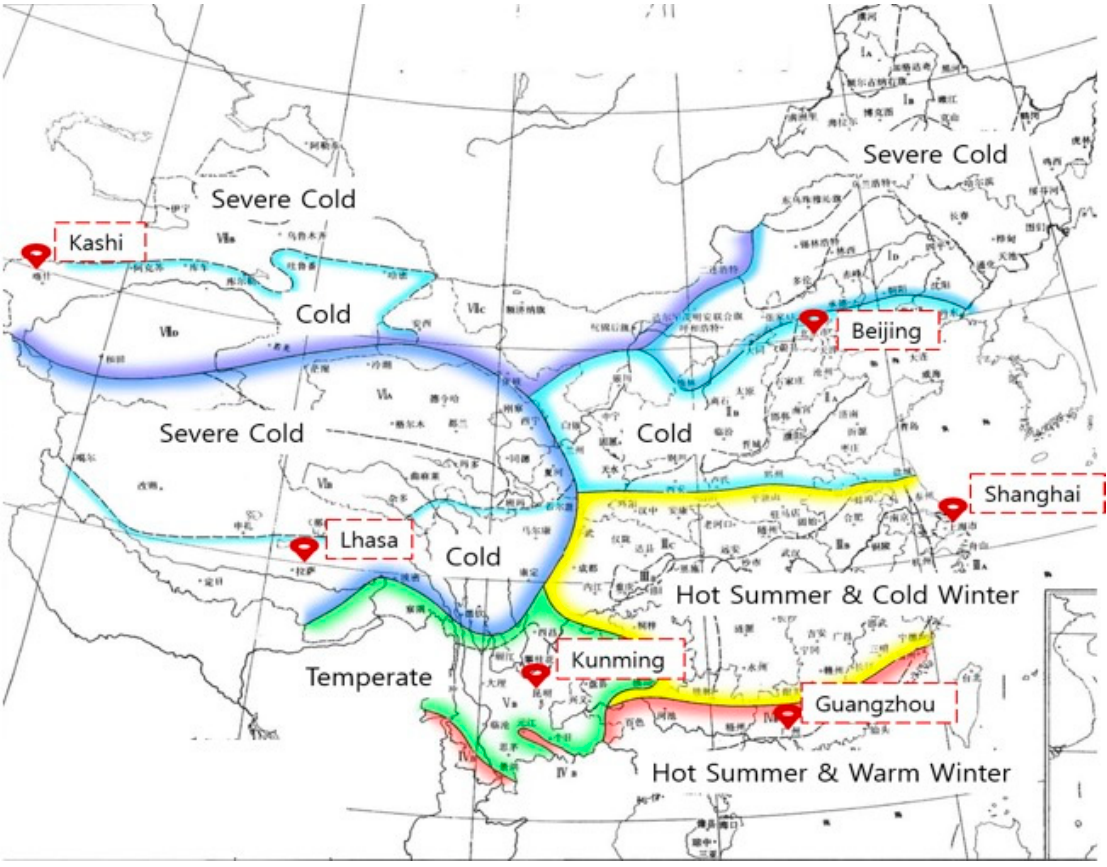
Figure 5. Selected cities on the climate distribution map of China. The six selected cities are part of six di ff erent climate regions, as shown in Figure 5. They are Beijing, Lhasa, Kashi (severe cold regions), Shanghai (hot summer and cold winter regions), Guangzhou (hot summer and warm winter regions), and Kunming (mild regions). These have distinctly di ff erent outdoor air conditions and di ff erent annual changes. The first three cities belong to a relatively dry climate region, Kunming is a relatively neutral climate region, and the rest are relatively humid climate regions. The di ff erences in the temperature and humidity ratios for the six selected cities can be seen in Figures 6 and